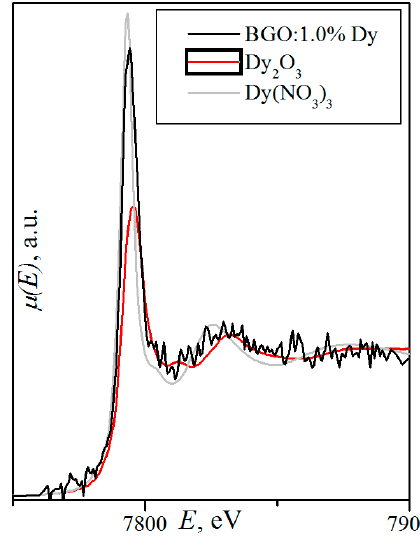
Figure 11. Dy L 3 -edge XANES data for the BGO:1.0Dy and reference samples: Dy 2 O 3 and Dy(NO 3 ) 3 .